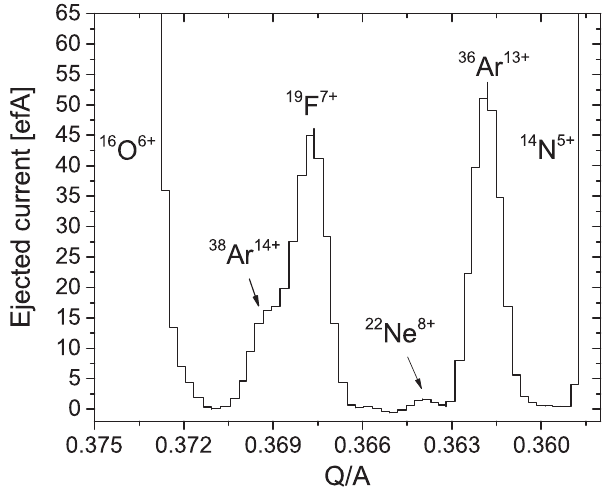
FIG. 14. Stable-isotope contaminants studied by scanning the field strength of the Q=A separator ’ s magnet while measuring ultra-low (efA level) beam currents with a Faraday cup.